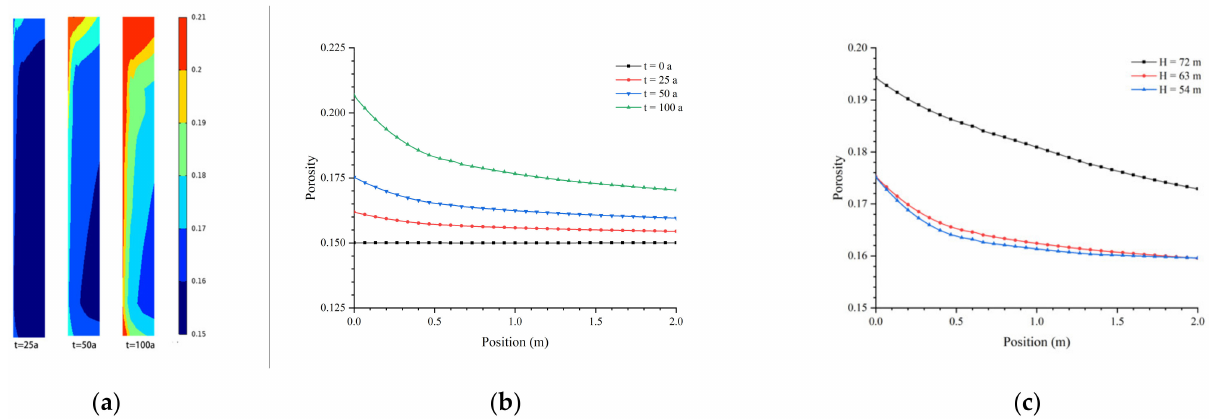
Figure 7. Impervious curtain porosity evolution in the leaching process: ( a ) porosity distribution; ( b ) porosity evolution at 63 m elevation in a century; ( c ) porosity evolution of three